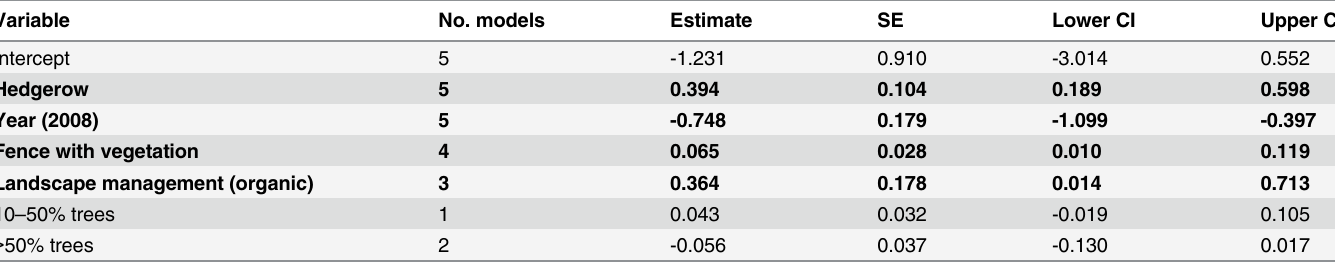
Results presented are those from averaging the fi ve top models where Δ AIC < 2; marginal R 2 = 0.48; conditional R 2 = 0.77. Farm ID is included as a random factor within the model. In all tables, terms considered to in fl uence the response variable where con fi dence intervals do not overlap zero are highlighted in